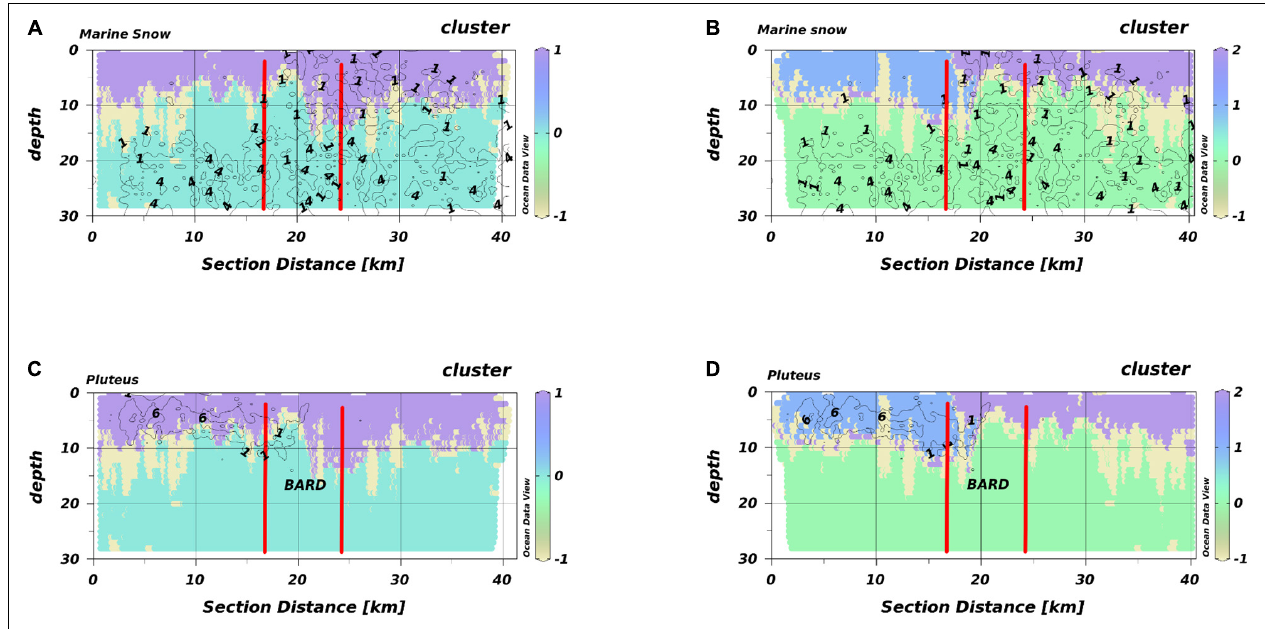
FIGURE 6 | HabitatMap of T2 (HE429) with marine snow density (A,B) and pluteus density (C,D) as isolines. The OWF BARD is located between the vertical red lines. (A,C) 3 segregated macro-habitats, (B,D) 4 segregated macro-habitats. Different colors represent different macro-habitats. Different numbers are the respective densities indicated by the isolines.